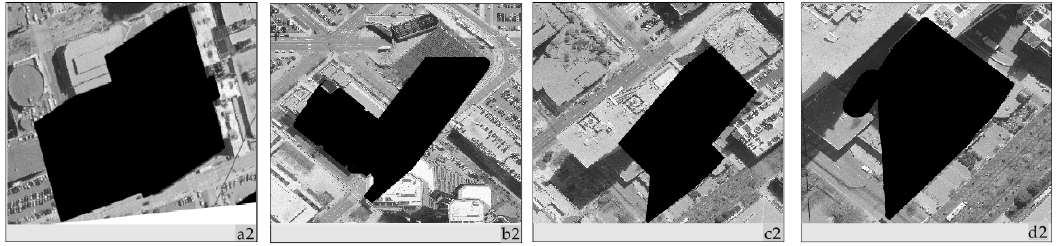
Figure 10. The shadows on the ground in the ghost images.